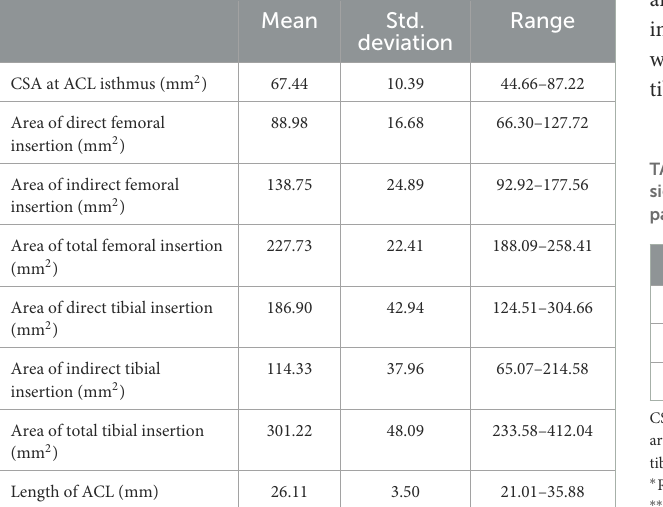
TABLE 2 Measurements of cross-sectional area (CSA) of ACL isthmus, area of ACL femoral insertion sites (direct, indirect, and total), area of ACL tibial insertion sites (direct, indirect, and total) and ACL lengths displayed as mean, standard deviation and range (min–max). Mean Std. deviation